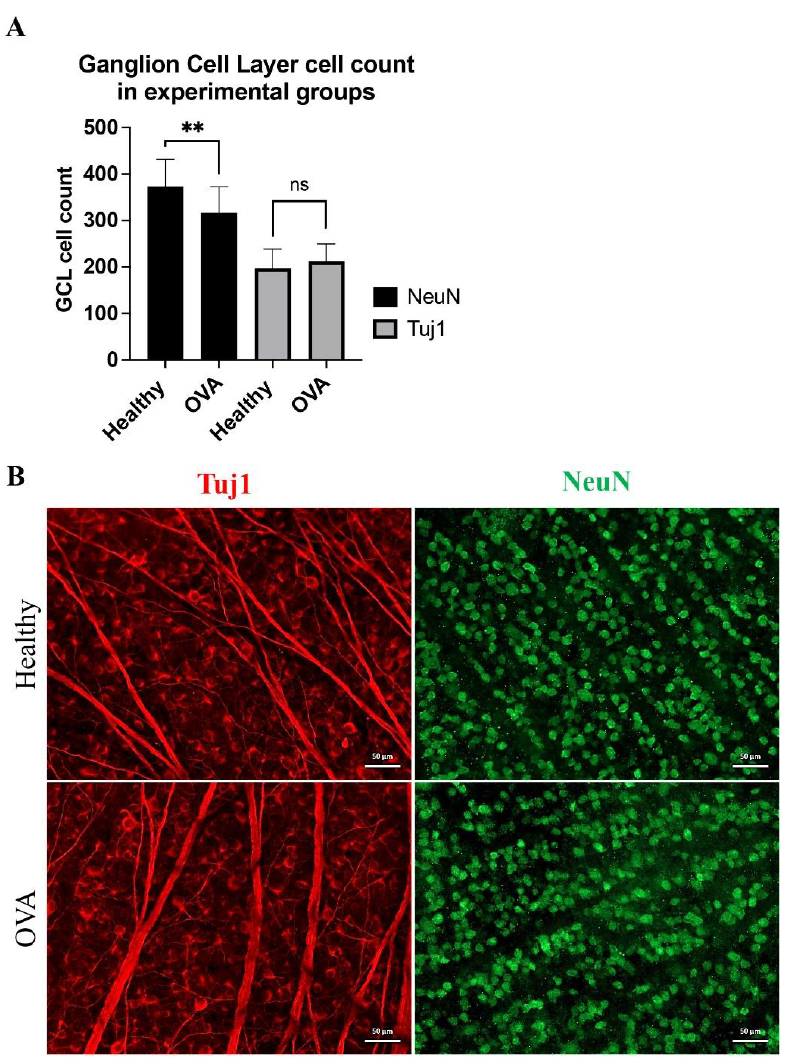
Figure 1. The impact of two weeks of surgical menopause on RGC and interneuron counts within the ganglion cell layer of the retina. ( A ) Statistical analysis of GCL cell count. ns: not significant, **: p < 0.01, Welch’s t test. ( B ) Immunofluorescence staining of the whole mounted retinas for Tuj1 (red) and NeuN (green). Scale bar: 50 µ